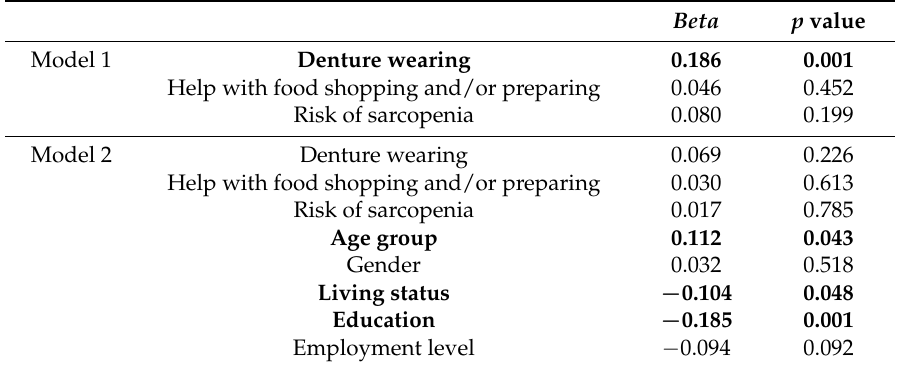
Table 2. Outcomes of the multiple linear regression model assessing the effect of physical disadvantage and demographic characteristics on food neophobia. Significant effects are given in bold ( p <